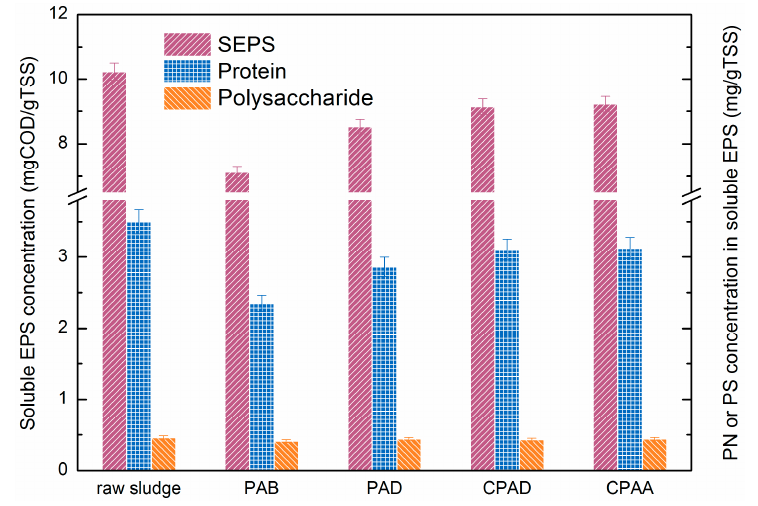
Figure 11. Effect of different flocculants on concentrations of SEPS and composition. SEPS: soluble extracellular polymeric substance